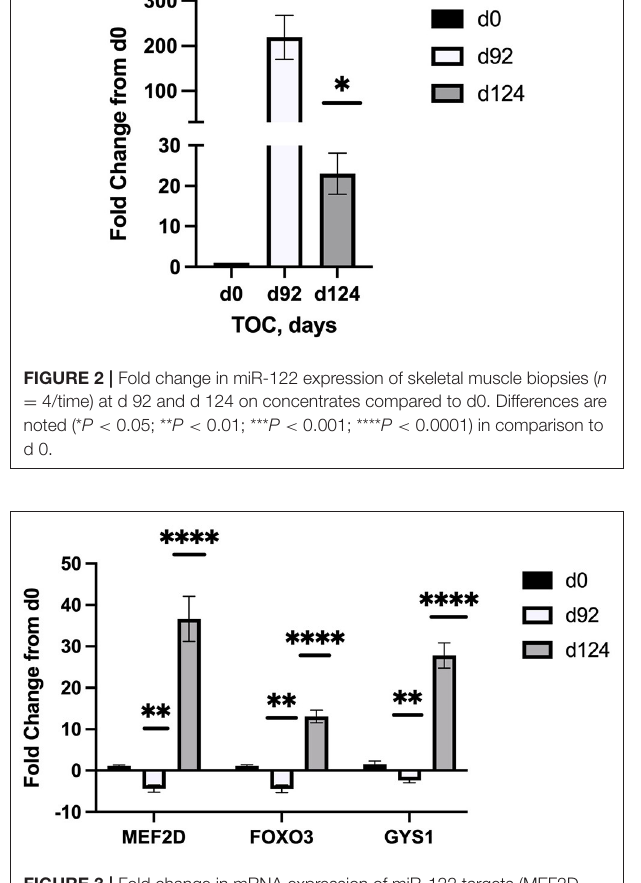
FIGURE 3 | Fold change in mRNA expression of miR-122 targets (MEF2D, FOXO3, GYS1) at d 92, and d 124 compared to d 0 (n = 4/time). Differences are noted (* P < 0.05; ** P < 0.01; *** P < 0.001; **** P < 0.0001) in comparison to d 0.